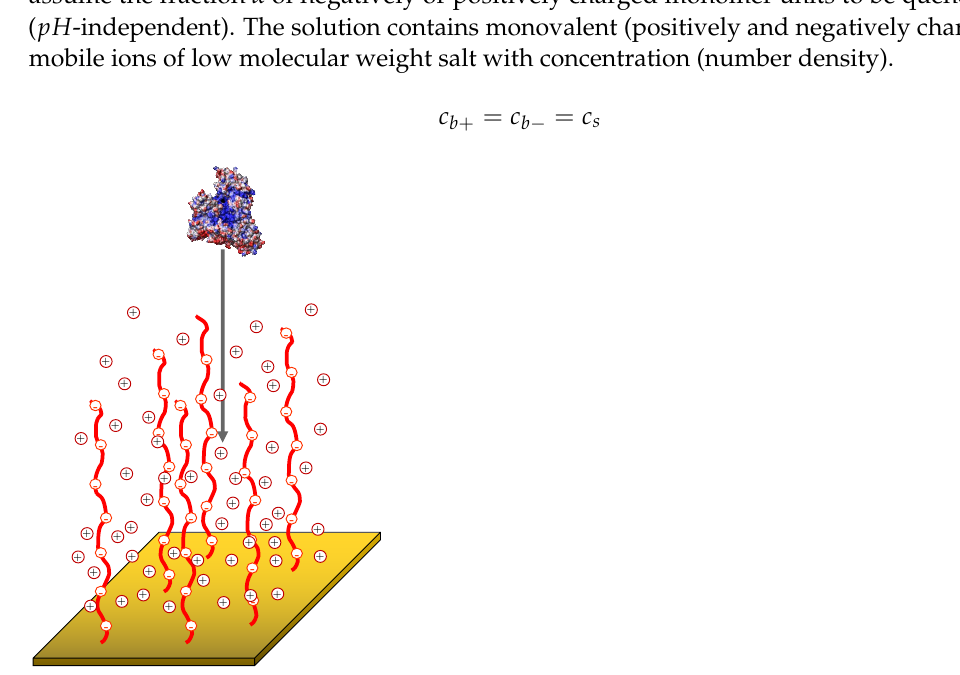
Figure 2. Schematics of the BSA globule insertion into the polyanionic brush. Mobile counterions (cations) are shown explicity. Blue, red and white patches on the globule surface correspond to anionic, cationic and neutral residues,